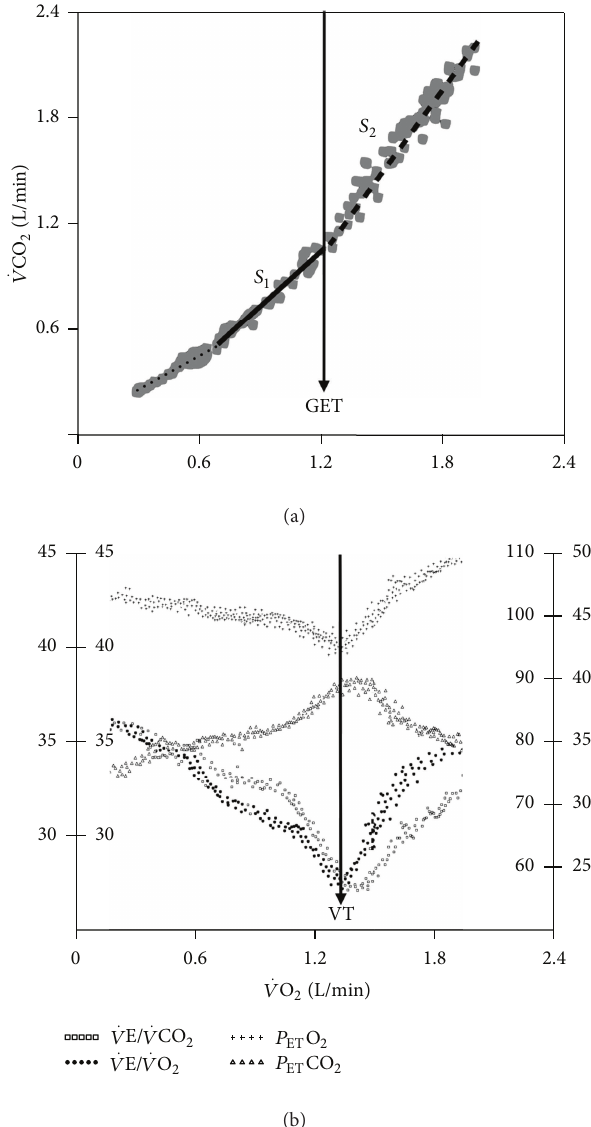
Figure 1: Noninvasive estimation of the lactate threshold by the 𝑉 -slope method (gas exchange threshold (GET), panel (a)) and the ventilatory method (ventilatory threshold (VT), panel (b)) in a normal subject. Note that the GET slightly precedes the VT as the later depends on the ventilatory response to the “extra-CO 2 ” generated by buffering of H + associated with (lactate) increase. 𝑆 1 and 𝑆 2 refer to the two sequential slopes (before and after the GET) with 𝑆 2 being characteristically steeper than 𝑆 1 (i.e., slope inclination >